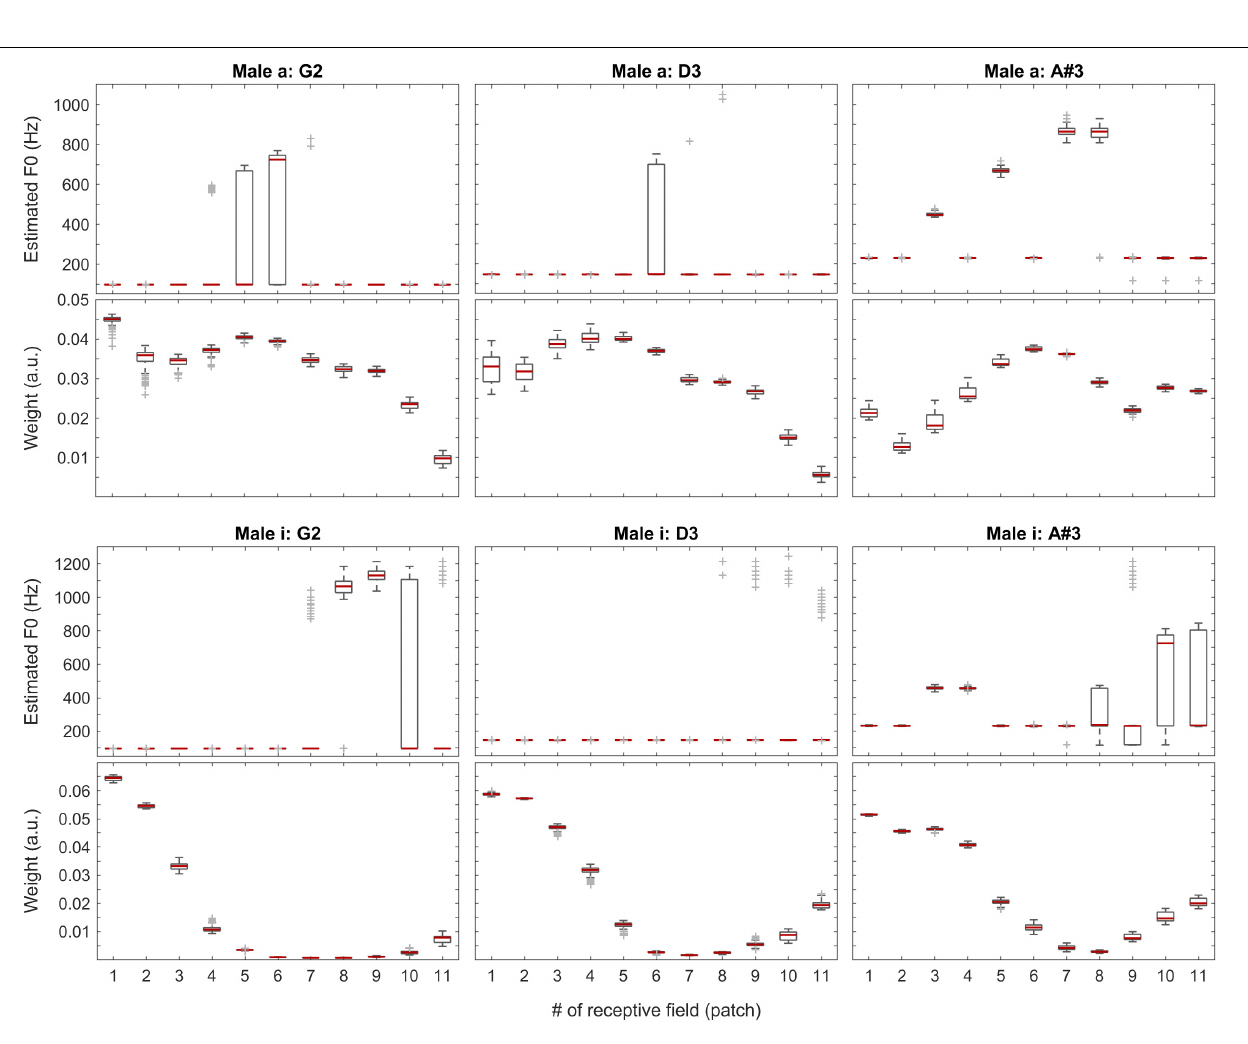
FIGURE 8 | F0 estimates (first and third rows) and weights (second and fourth rows) for all patches over all 100 iterations for the vowels a: (top two rows) and i: (bottom two rows) sung by a male